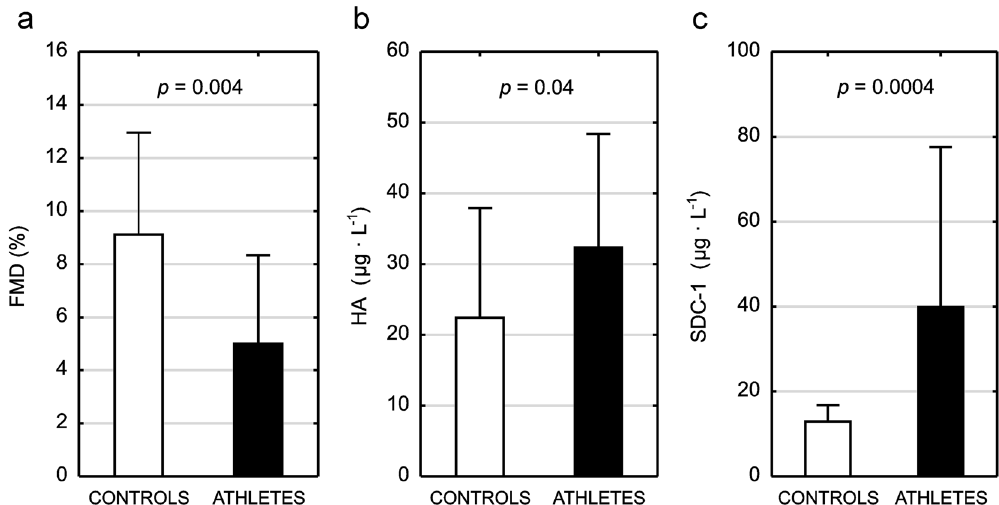
Figure 2. Endothelial function and glycocalyx layer integrity markers in female athletes and age-matched control group. Flow-mediated dilation (FMD—panel a ); hyaluronic acid (HA—panel b ), syndecan-1 (SDC-1— panel c ).